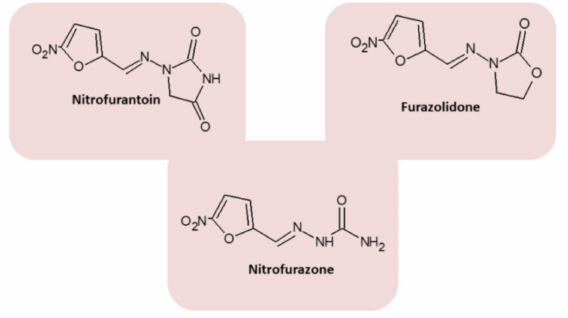
Figure 1. Commonly used antimicrobial agents with hydrazide–hydrazone